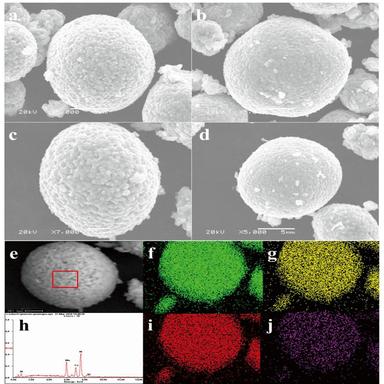
SEM images of W-0 (a), W-0.5 (b), W-1 (c), W-1.5(d) and the EDS mapping results of W-1: (f) Ni, (g) Co, (i) Mn, (j)W and the EDS spectrum(h).